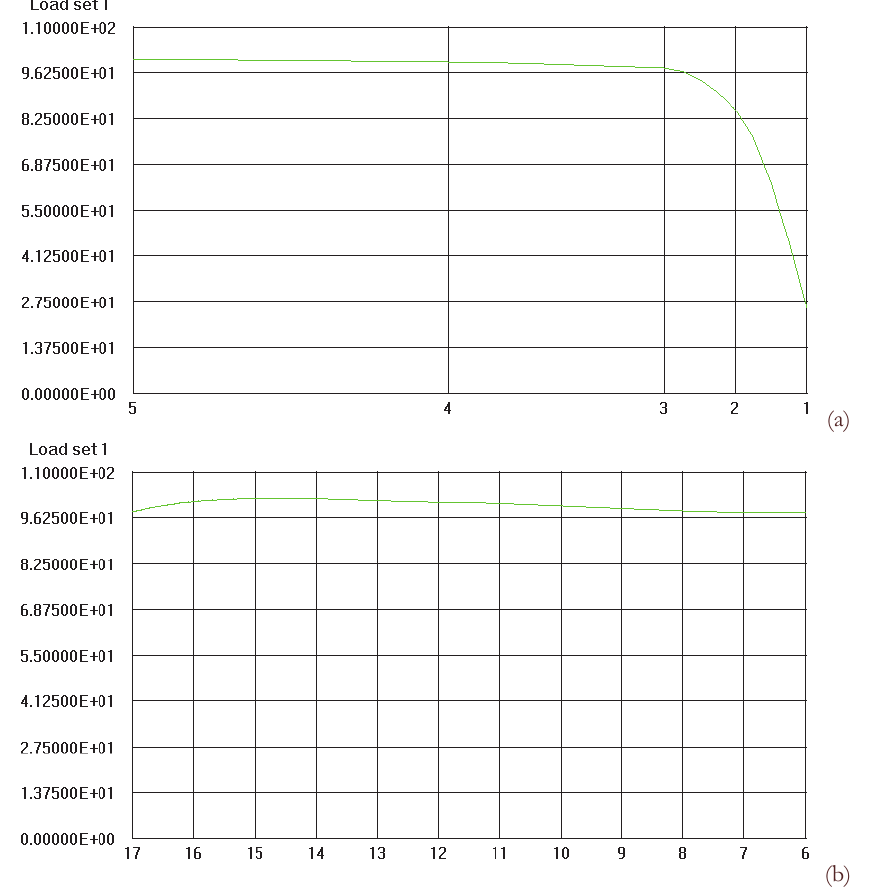
Figure 3: Membrane longitudinal stresses  yy on transversal section at y=54.25 mm (a); longitudinal stresses  yy on longitudinal section at x=110 mm